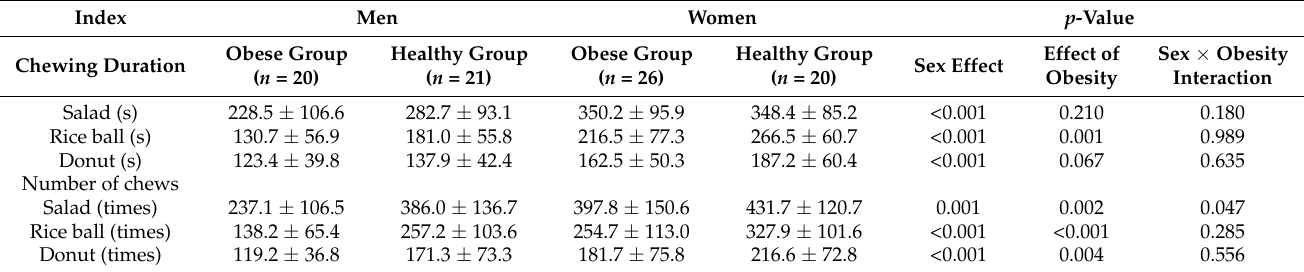
Table 2. Comparison between the study groups’ mastication duration and number of chews for each